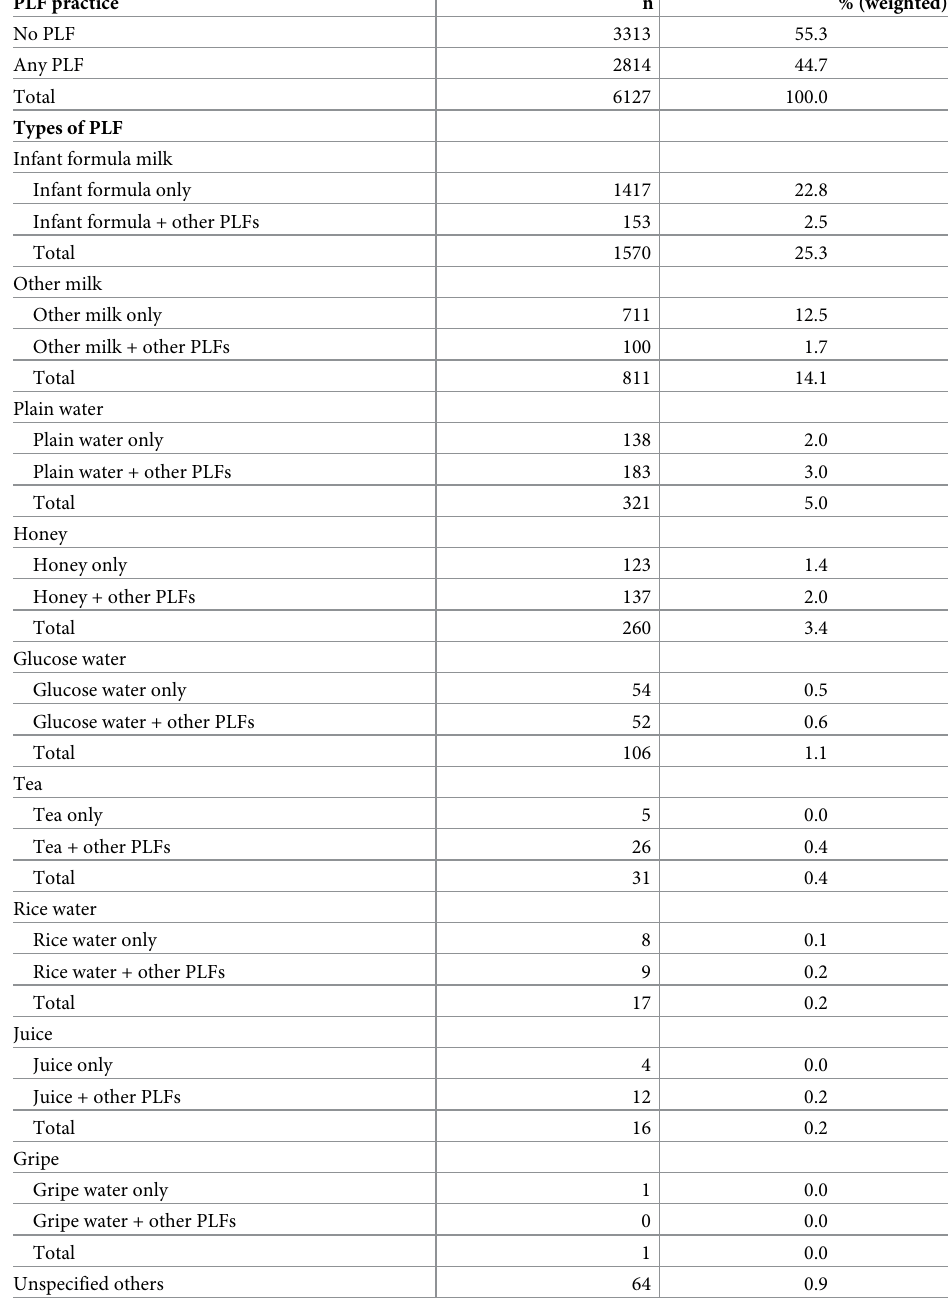
Table 2. Prevalence of PLF: Overall and by types of feed according to IDHS